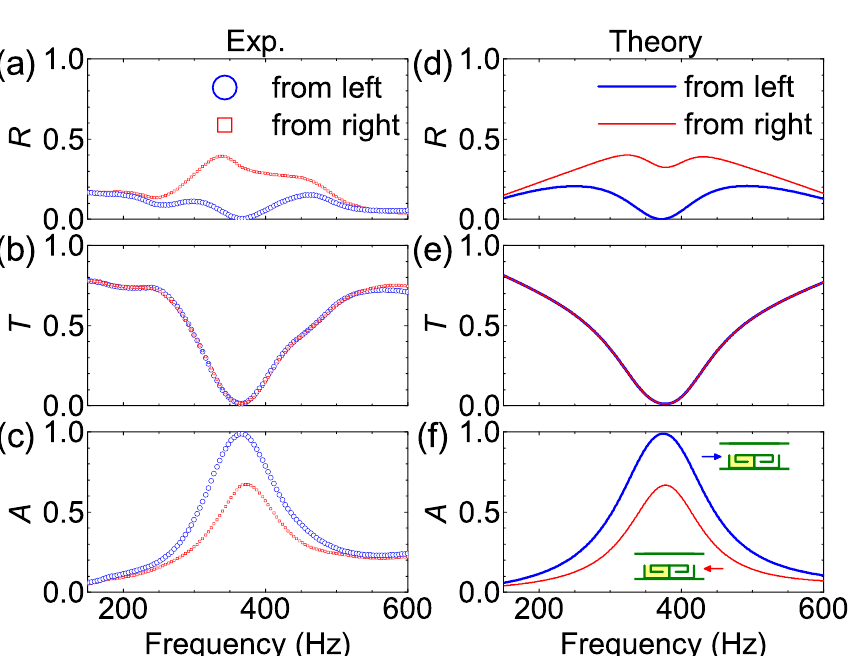
Figure 5. Performance of a 3D printed bilayer labyrinthine metasurface with spacing d = 0 and open area ratio p o = 0.5 . The left curled channel in the unit cell contains an appropriate amount of porous media, and the right curled channel is hollow. Other parameters are a = 43 mm, b = 107 mm, and t = 1 mm. ( a )–( c ) Measured reflection, transmission, and absorption spectra. ( d )–( f ) Calculated reflection, transmission, and absorption spectra. Blue and red symbols/curves are for sound waves incident from the left and right,